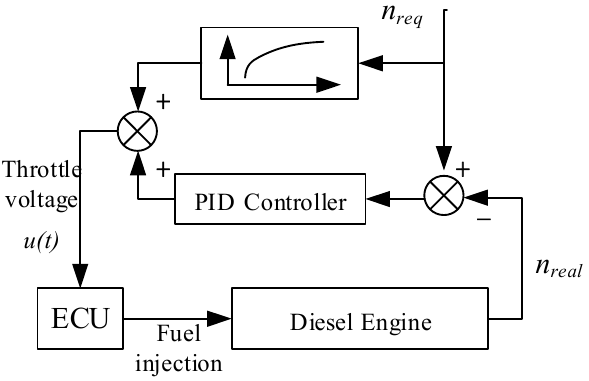
Figure 10. Engine speed feed forward and feedback proportional–integral–derivative (PID) control.